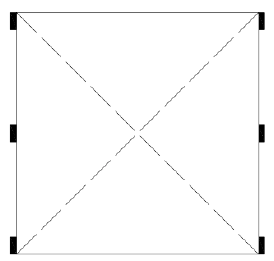
Figure 15. Plan of the building showing locations of rubber bumpers.